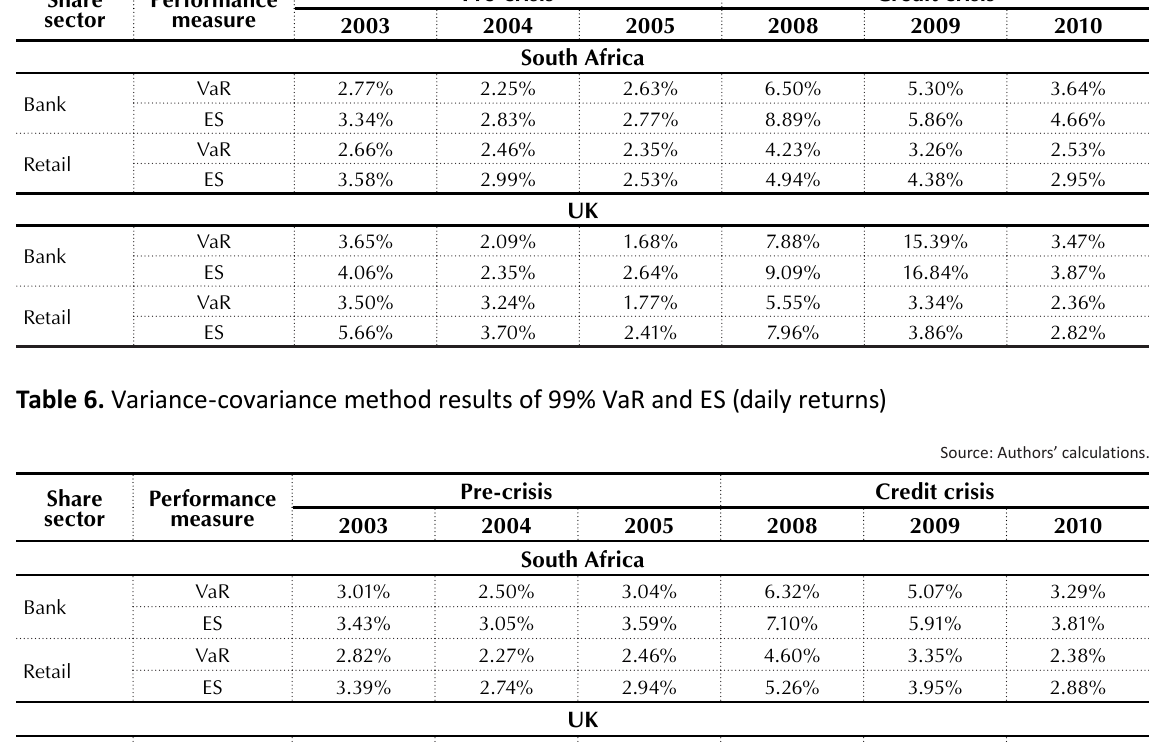
Source: Authors’ calculations.